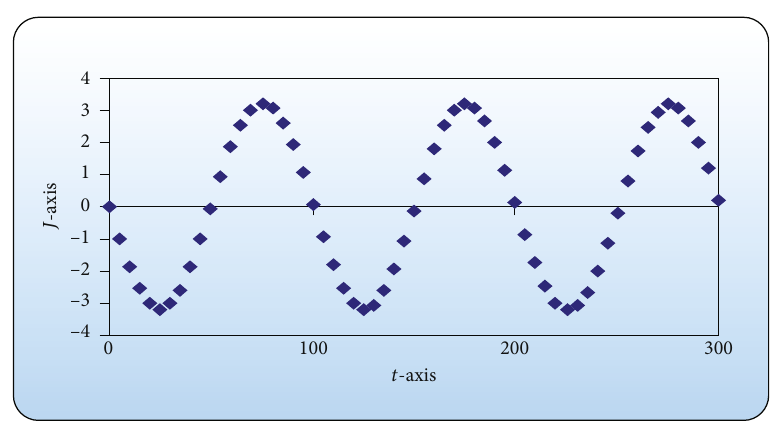
Figure 4: The numerical solution J = x